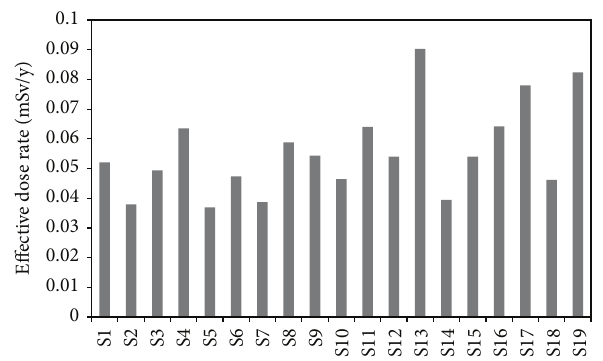
Figure 5: Effective dose rate for all samples.